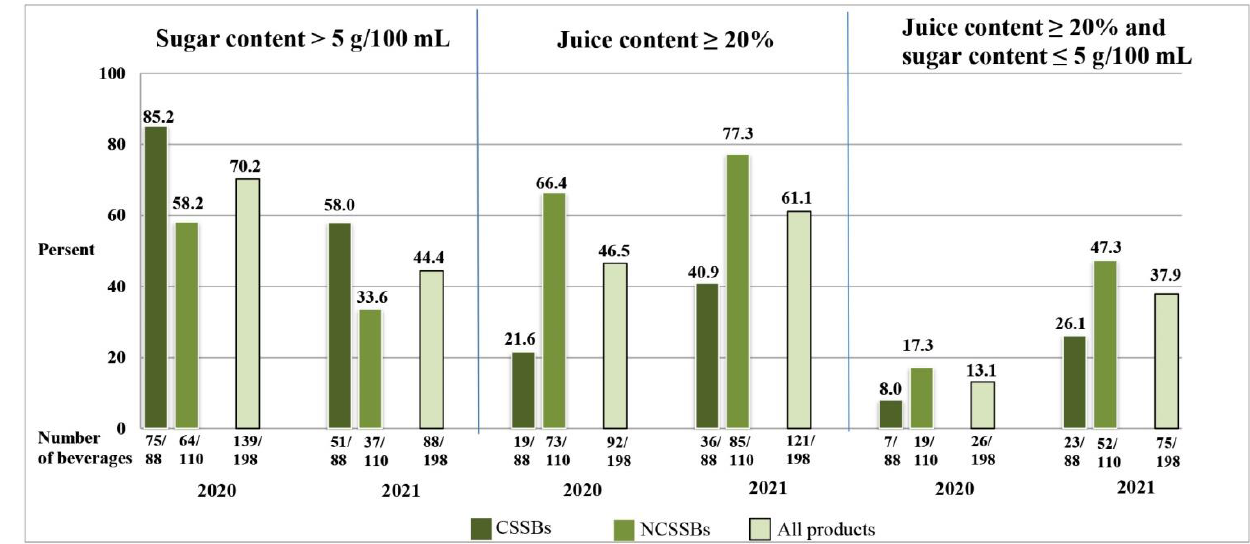
Figure 1. The characteristics of beverages in terms of the sweetened beverages tax criteria.